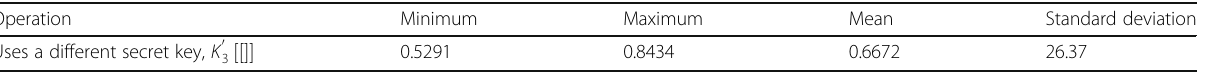
Table 11 Analysis of key dependence of image hash for 6042 image pairs Operation Minimum Maximum Mean Standard deviation ½½(cid:3)(cid:3) Uses a different secret key, K 0 3